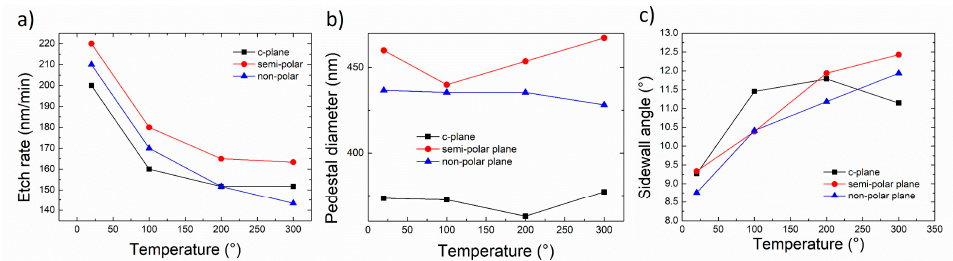
Figure 8. ( a ) Etch rate, ( b ) base diameter and ( c ) sidewall angle of c -plane, (1122) semi-polar and (1120) non-polar GaN layers as a function of temperature.